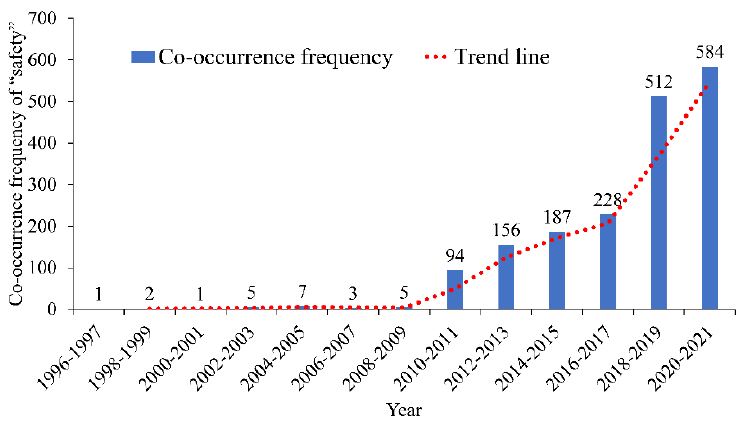
Figure 4. Co-occurrence frequency and time distribution of “safety”.